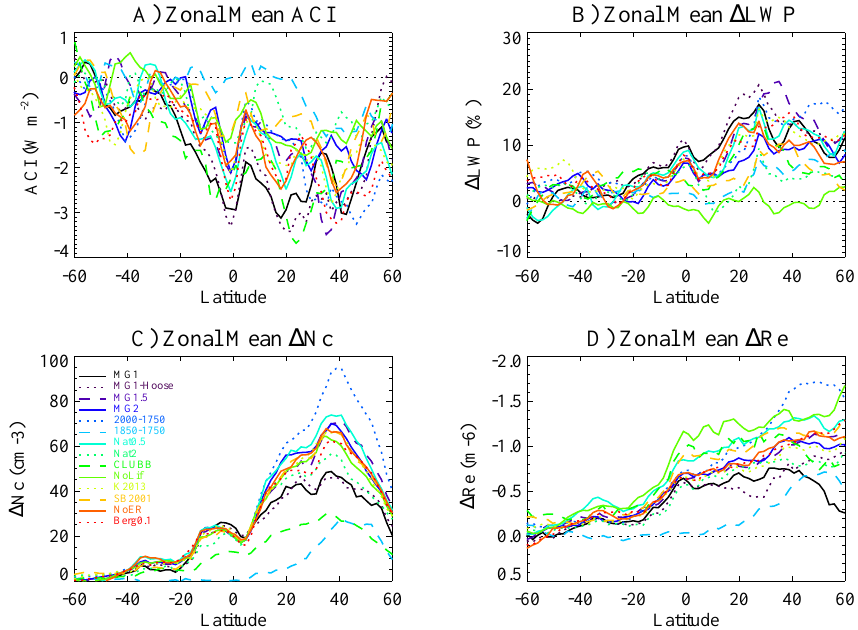
Figure 6. Zonal mean (a) ACI (change in CRE, Wm − 2 ), (b) percent change in LWP, (c) change in cloud-top drop number concentration ( (cid:49)N c , cm − 3 ) and (d) change in cloud-top effective radius ( (cid:49) Re, m − 6 ) for different sensitivity tests noted with colors and different line styles.